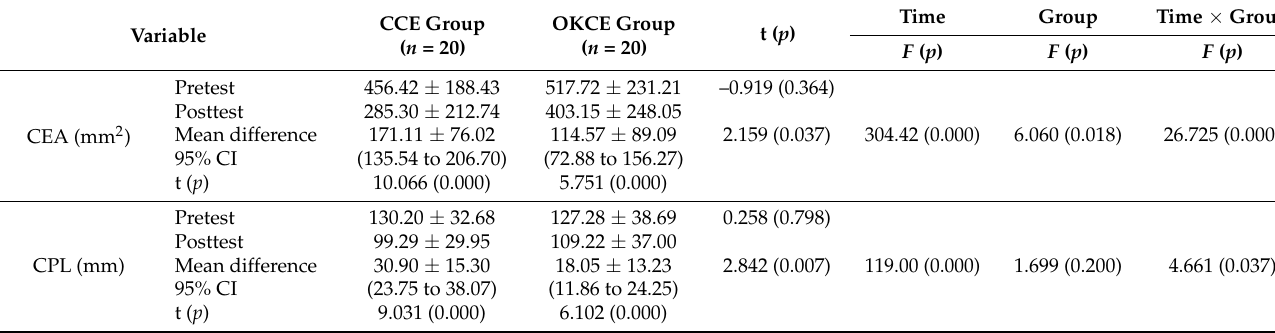
Table 5. Comparisons of balance